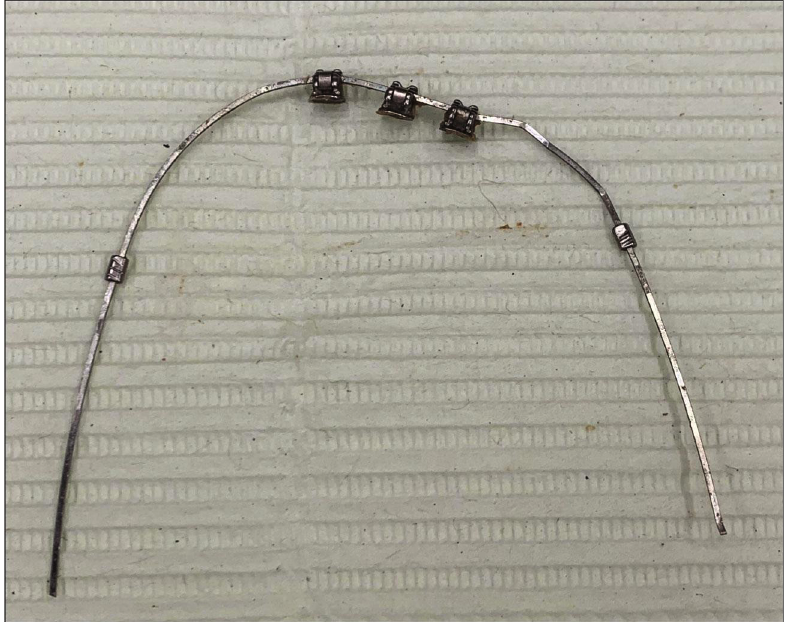
Figure 6: Photograph of the deformed 0 : 016 ″ × 0 : 022 ″ SS wire from the mandibular dental arch after dental trauma. The impact of the trauma had detached the brackets from the mandibular right central and lateral incisors and the mandibular left central incisor.